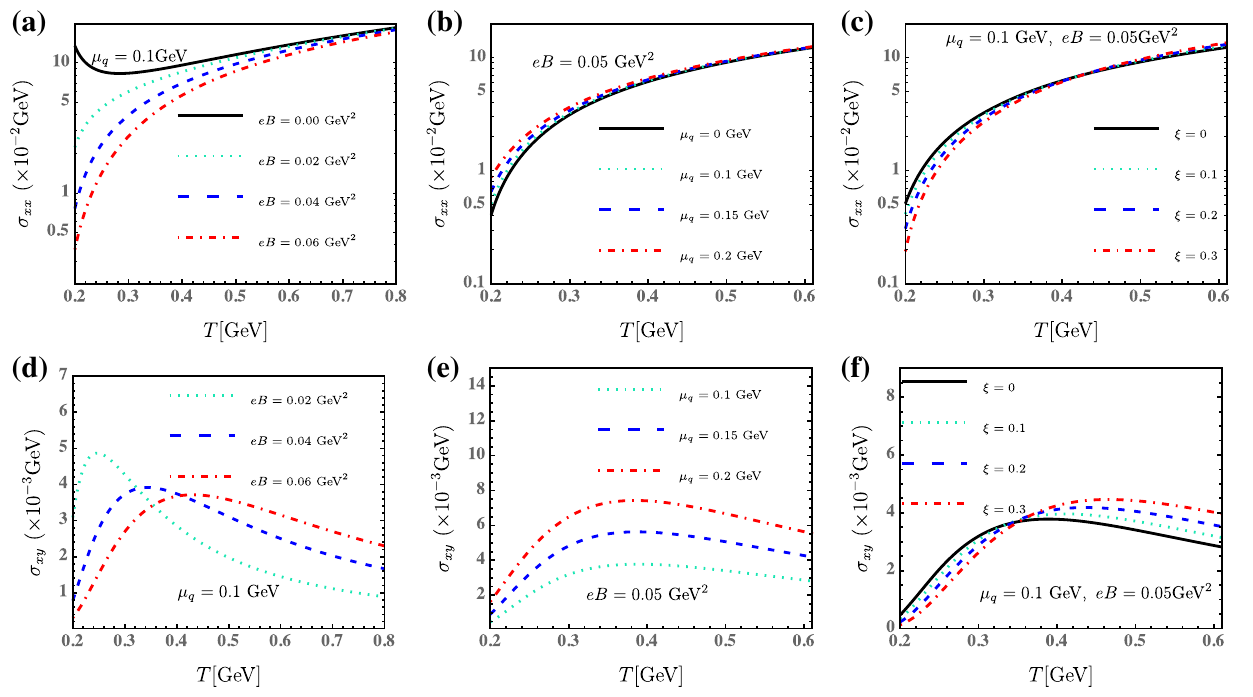
Fig. 2 a , d The temperature dependences of the electrical conduc- tivity ( σ xx ) and the Hall conductivity ( σ xy ) for μ q = 0 . 1 GeV at different weak magnetic fields, namely, eB = 0 GeV 2 (black solid line), 0.02 GeV 2 (cyan dotted lines), 0.04 GeV 2 (blue dashed lines), 0.06 GeV 2 (red dotted-dashed lines). b , e The temperature dependences of σ xx and σ xy for eB = 0 . 05 GeV 2 at μ q = 0 GeV (black solid line),